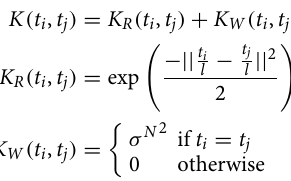
(cid:30) at each time